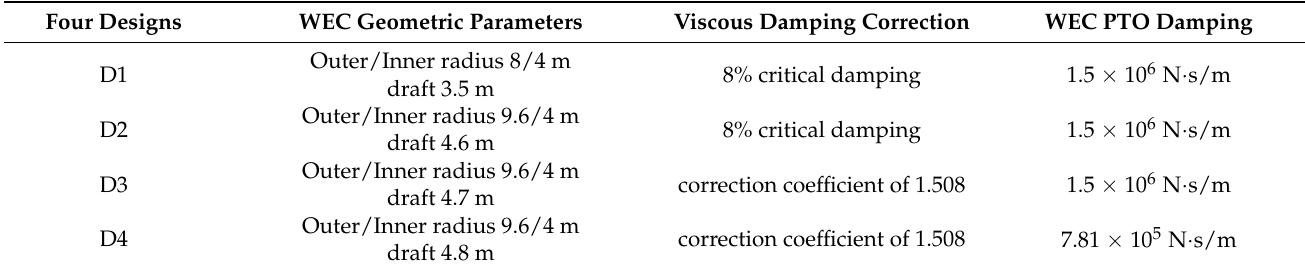
Table 2. The main characteristics of the four